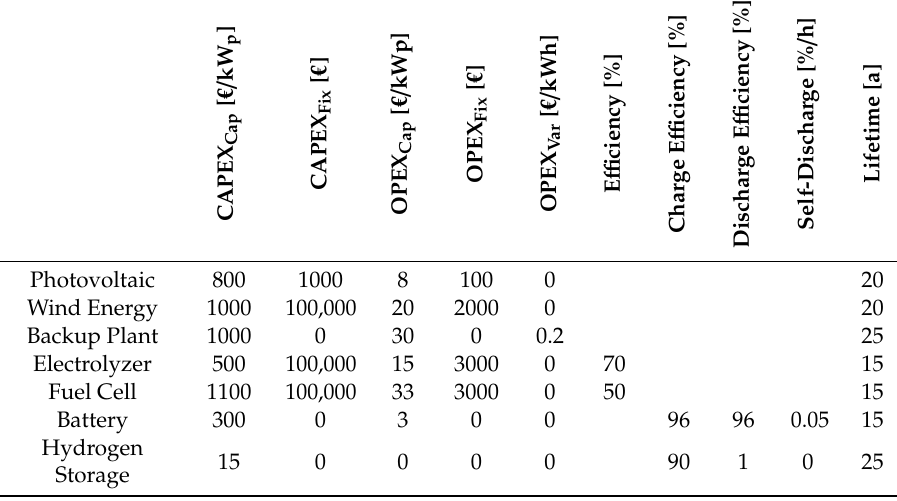
Table 5. Unit parameters of the island system derived from Kotzur et al. [37].